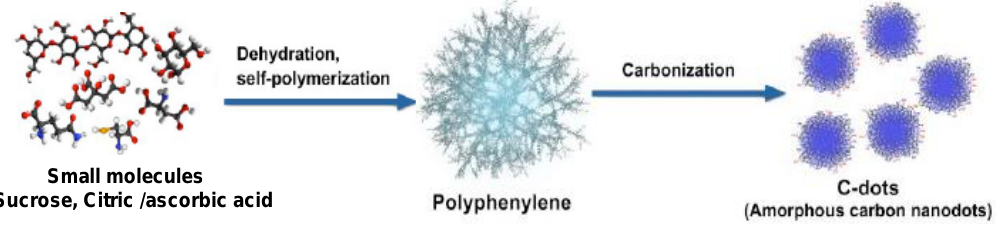
Fig.1: The schematic illustration for CQDs preparation [10].